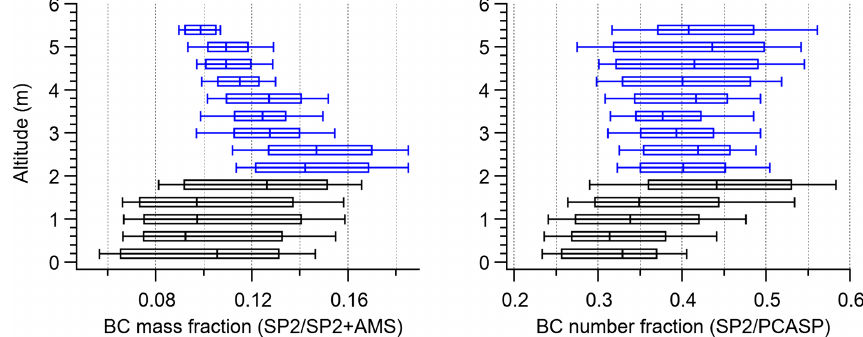
Figure 11. The vertical distributions of BC mass fraction and number fraction in the BB-polluted FT (blue) and BL (black) respectively. The box-and-whisker plots represent the 10th percentile, 25th percentile, median, 75th percentile and 90th percentile in every